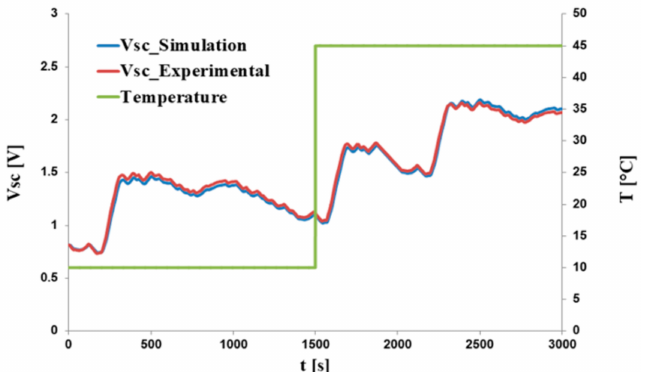
Figure 7. Sc cell terminal voltages obtained from experimental and simulations tests.